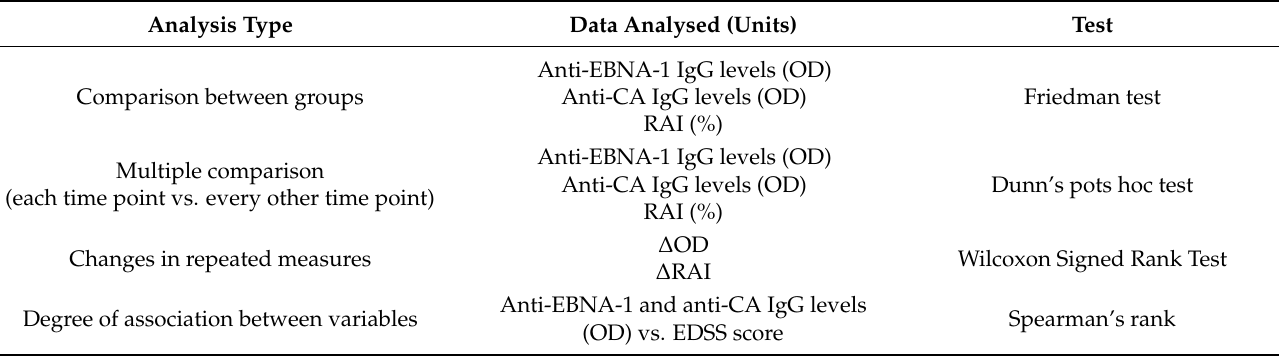
Table 3. Overview of statistical tests used in the manuscript. CA, Epstein–Barr virus (EBV) capsid antigen; EBNA-1, EBV nuclear antigen 1; EDSS, expanded disability status scale; OD, optical density; RAI, relative avidity index; ∆ OD and ∆ RAI, changes in OD or RAI values, respectively, between two different time points (e.g., T1 minus